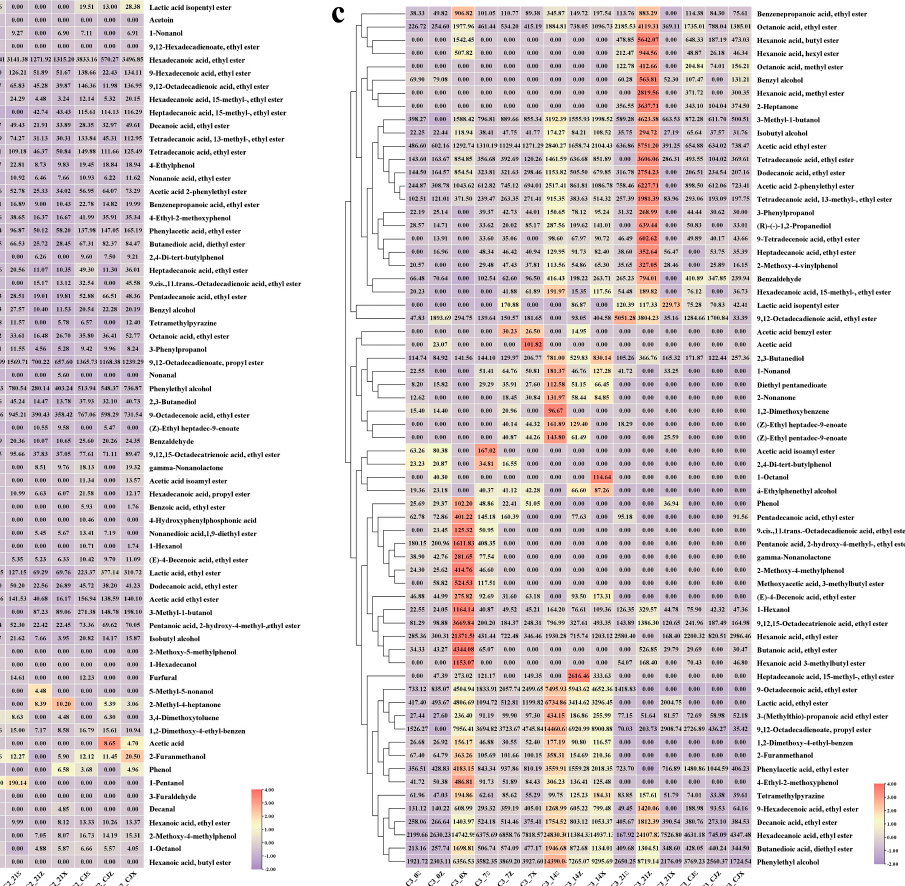
Figure 2. Flavor chemical analysis of the fermented grains from rounds 1b, 2, and 3 during the sauce-flavor Baijiu manufacturing process. ( a ), round 1b. ( b ), round 2. ( c ) round 3.